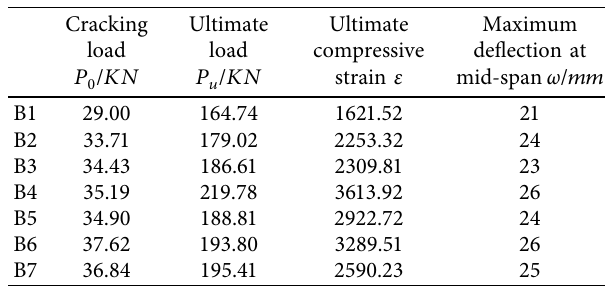
Table 3: Test results.